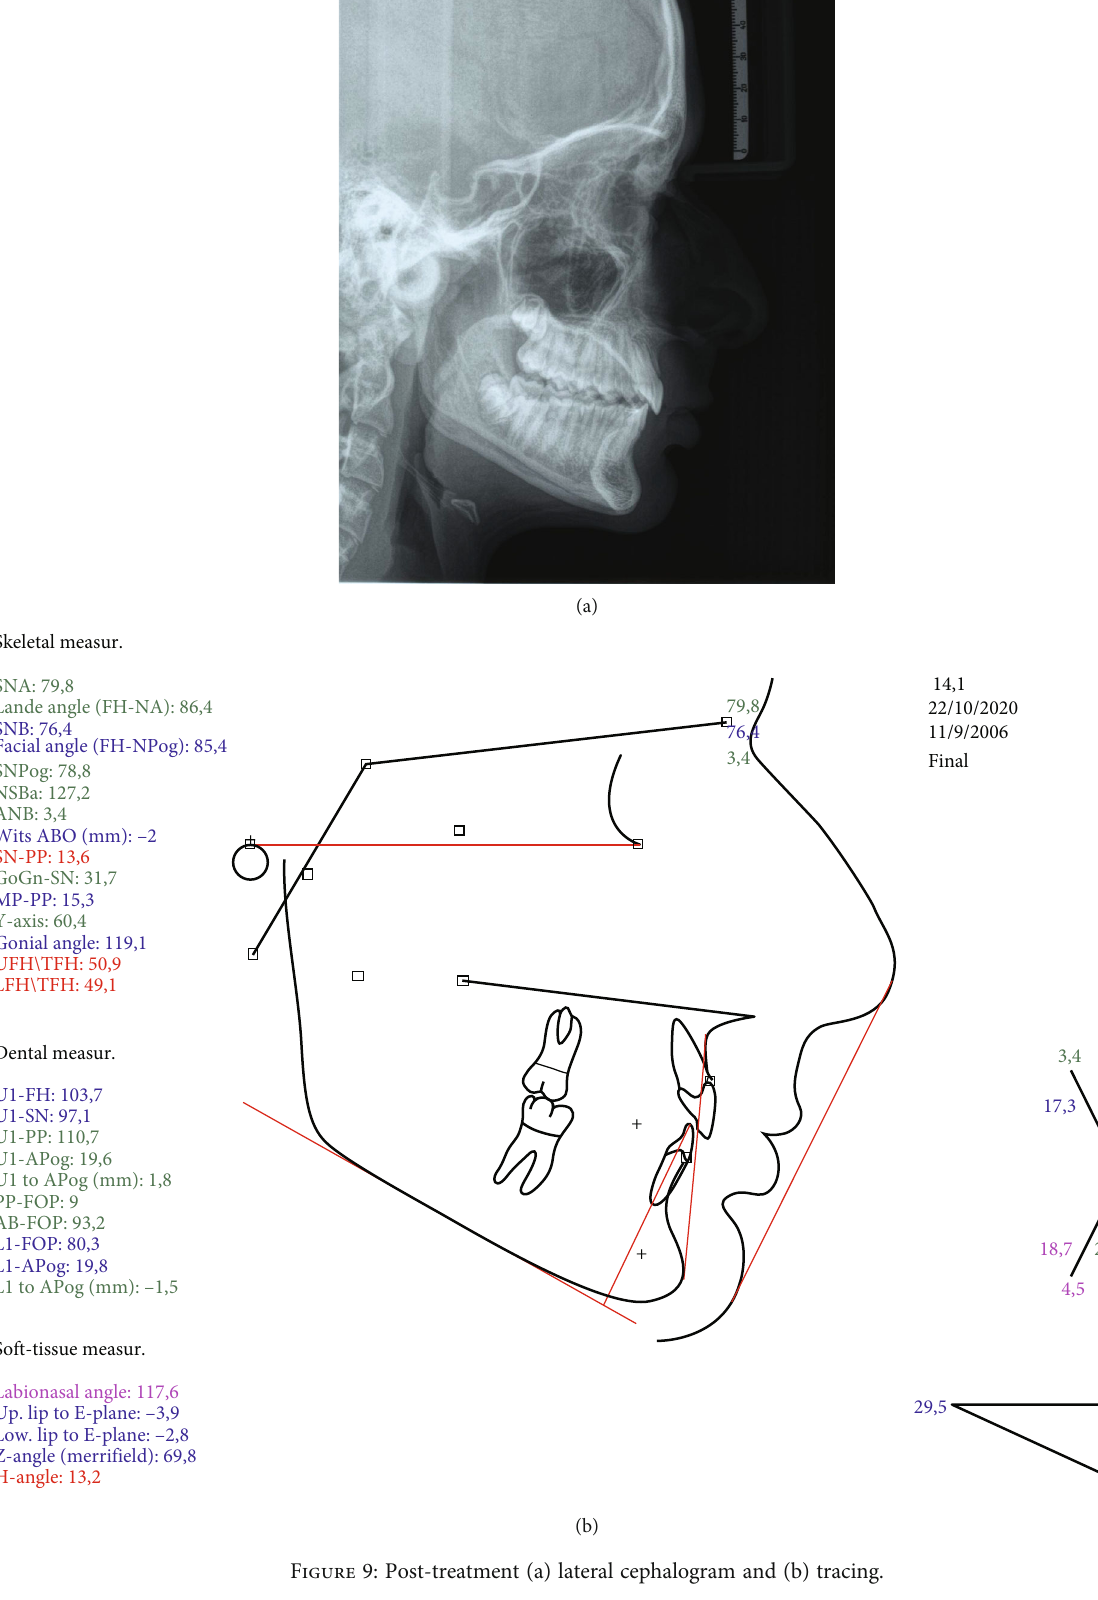
Figure 9: Post-treatment (a) lateral cephalogram and (b)